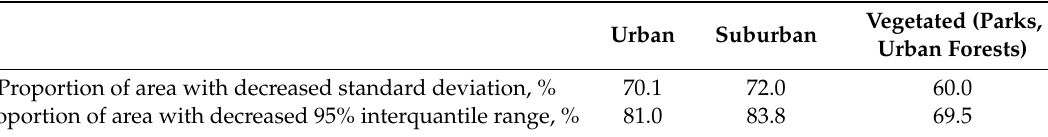
Table 1. Proportion of area with substantial decrease in dispersion metric (decrease of more than 1.0 m) for three land-use categories in our urban study region. The proportion of area with increases were very small (less than 0.1%) and hence, we do not report them